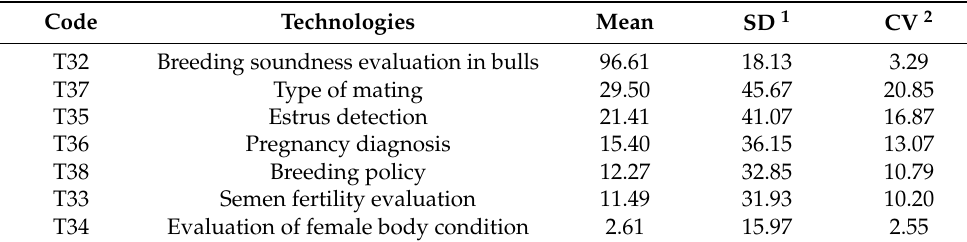
Table 3. Reproductive technologies in dual-purpose cattle